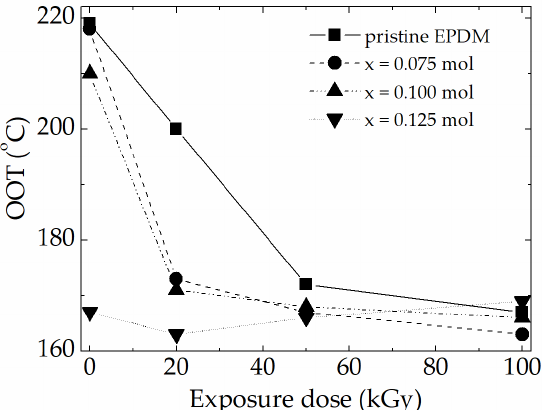
Figure 8. The histogram of OOT values obtained for eight coordinative compounds of copper with various ligands at three heating rates (°C min − 1 ): ( white ) 5; ( dark grey ) 10; ( black ) 15 [134]. The evidence on the radiation effects on EPDM nanohybrids is provided by the ageing investigation achieved on the EPDM/silica composites [135]. The destructive effect of diene content (EBN at 0.5 phr) is annihilated by the contribution of nanoparticle silica loading, which reinforces the EPDM microstructure by the formation of multiple bridges between polymer macromolecules. The high proportion of propylene units in the EPDM backbones (29.9%) brings about a decomposition susceptibility by which the γ -irradiation allows access to the reactive intermediated for the crosslinking on the surface of silica nanoparticles, though the molecular branching acts as a cage in the hybrid materials. The polymer blends with a continuous morphology, where both components playing the role of radical source, such as SBR and EPDM, are the suitable hybrid materials for many products that demand a dense but elastic material showing a convenient oxidation strength. An appropriate example is the formulation consisting of SBR/EPDM = 50:50 and nanoclay particles crosslinked with sulfur or by γ -irradiation [136], where filler